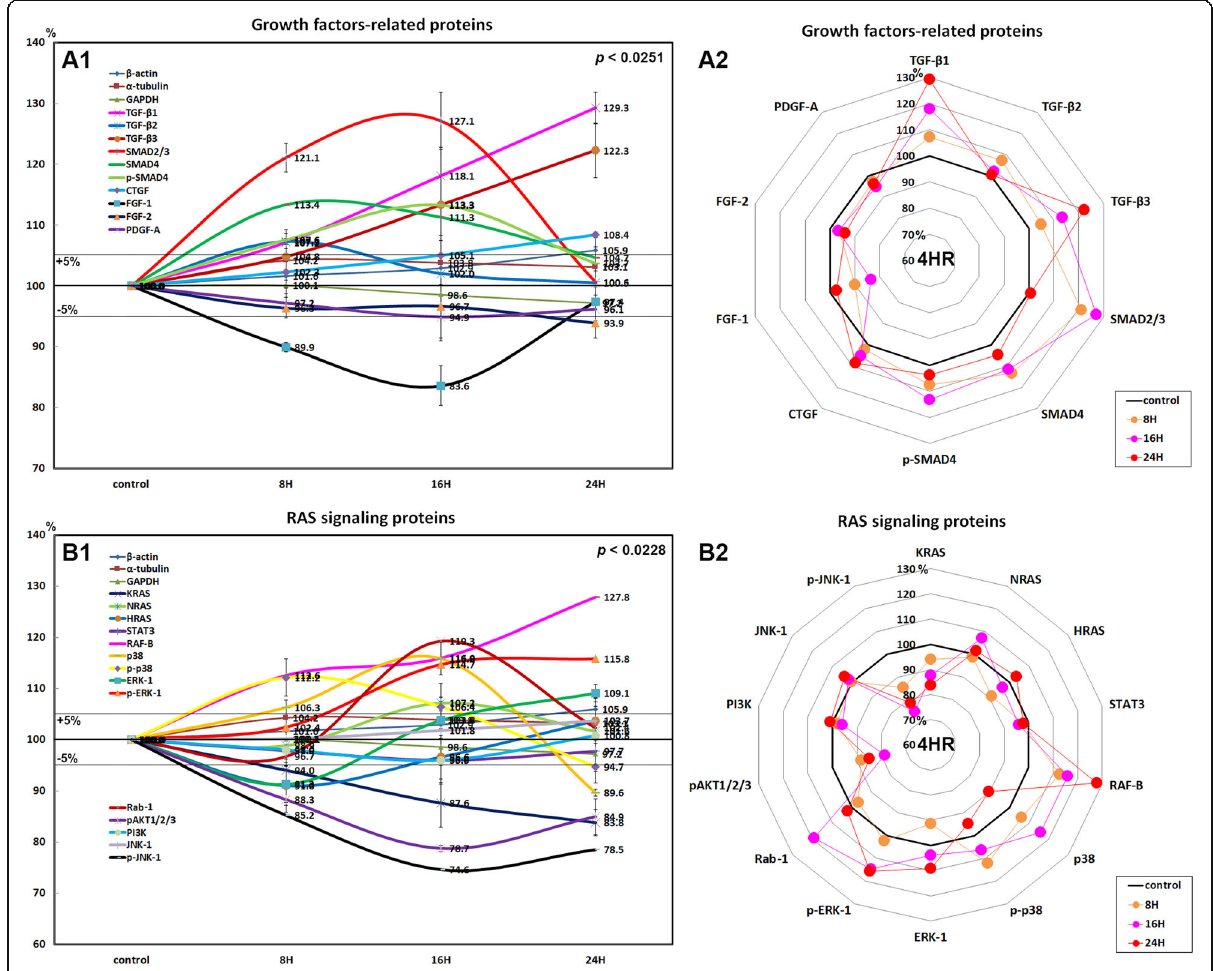
Fig. 1 Expressions of growth factor-related proteins ( A1 , A2 ) and RAS signaling proteins ( B1 , B2 ) in 4HR-treated HUVECs as determined by IP- HPLC. The line graphs ( A1 , B1 ) show protein expression patterns on the same scale (%) versus culture time (8, 16, or 24 h), whereas the star plots ( A2 , B2 ) show the differential expression levels of proteins in a circular manner after 8, 16, or 24 h of treatment on appropriate scales